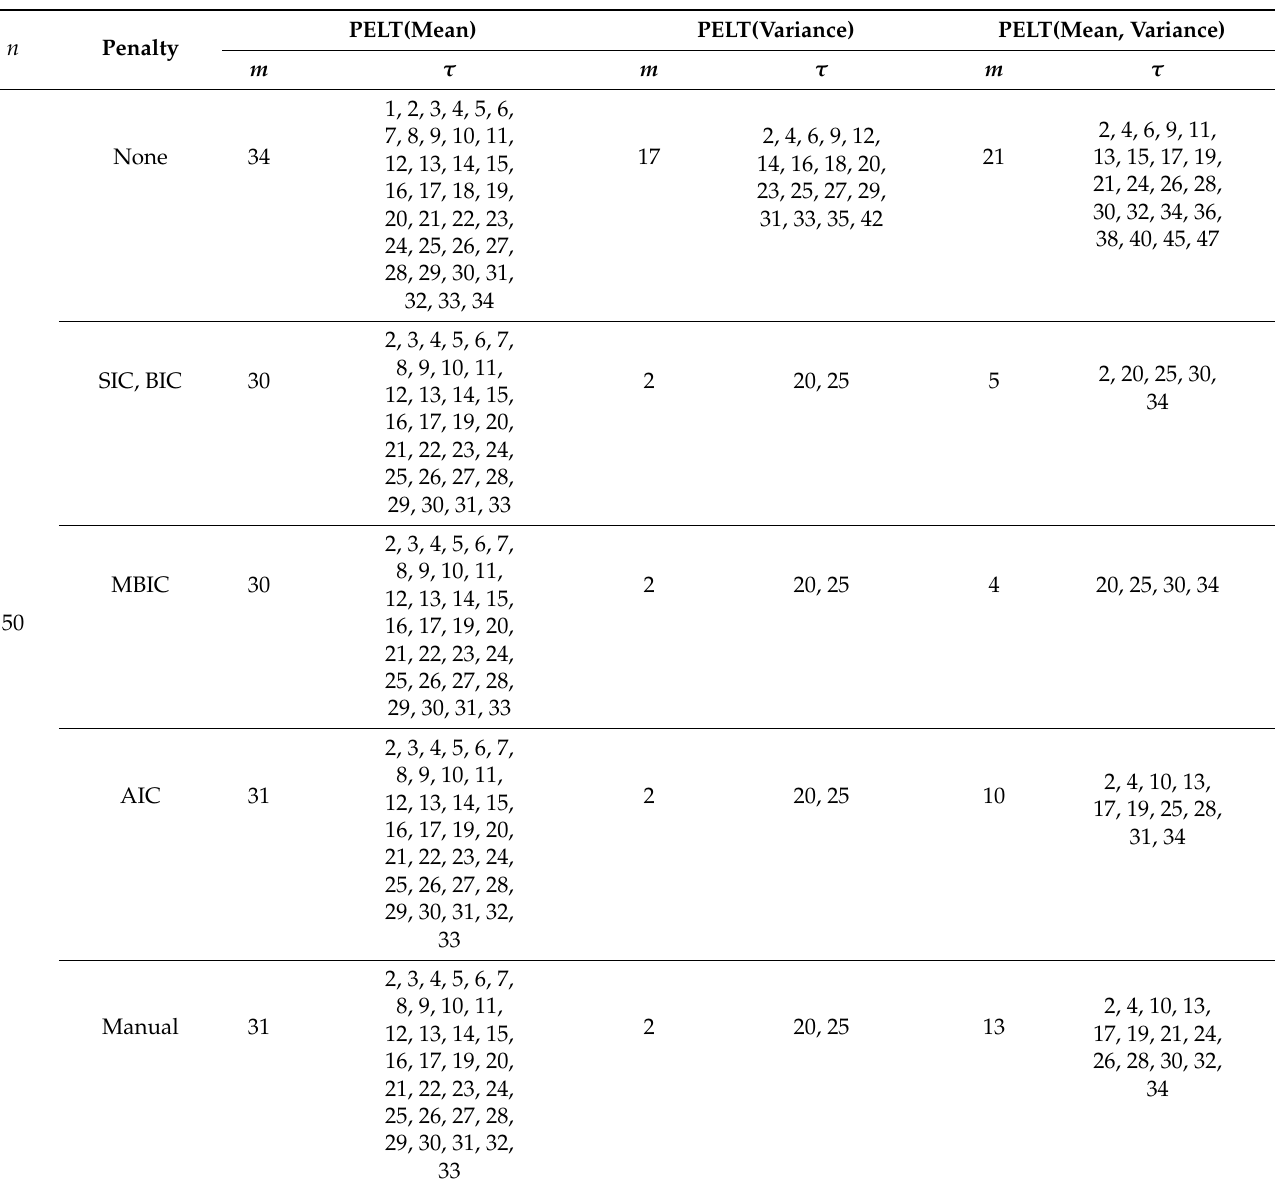
Table A4. PELT Algorithm Result for Simulated